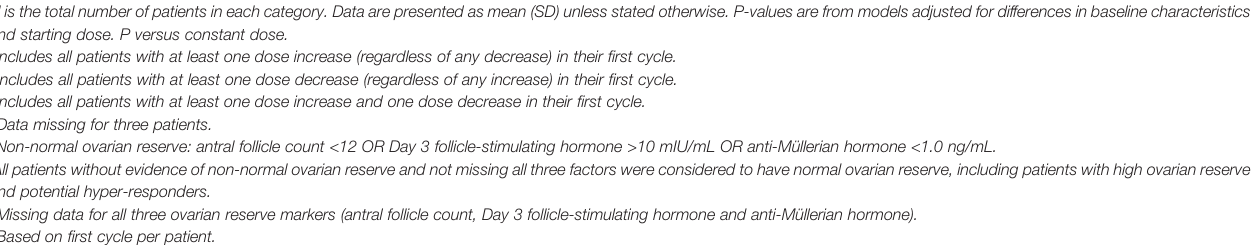
patients with no dose adjustment had a non-normal AFC (<12 versus 31%) ( Supplementary Table 1 ).